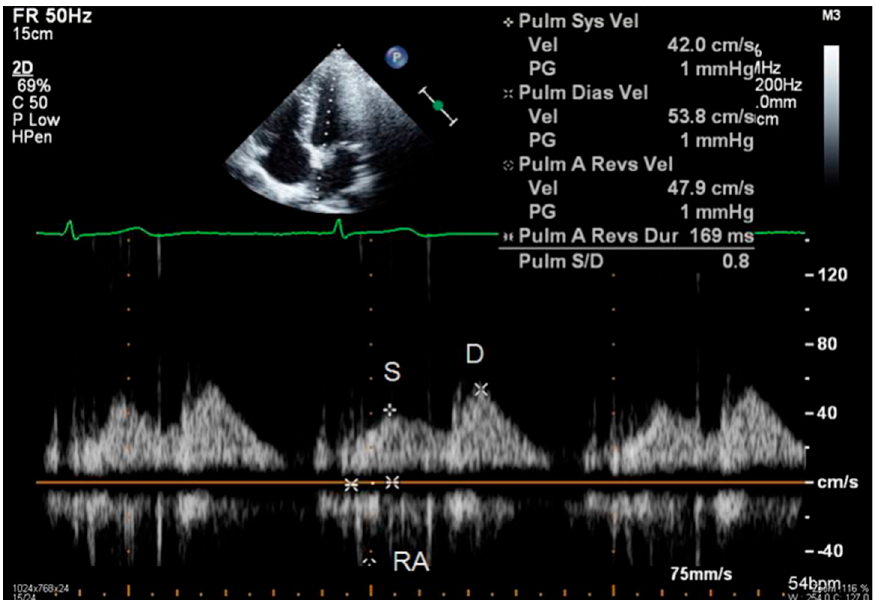
Figure 6. Echocardiographic measurement of S and D wave peak velocity by pulsed Doppler on right superior pulmonary vein flow. D: peak velocity of diastolic wave: RA: peak velocity of reverse atrial wave; peak S: peak velocity of systolic wave.